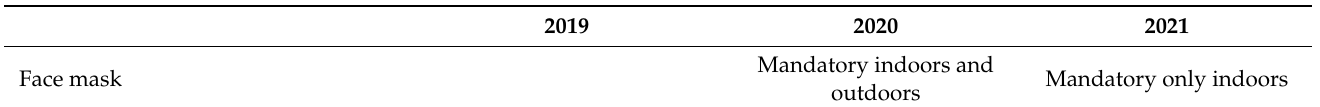
Table 2. Governmental NPIs during fall season of 2019, 2020, and 2021.